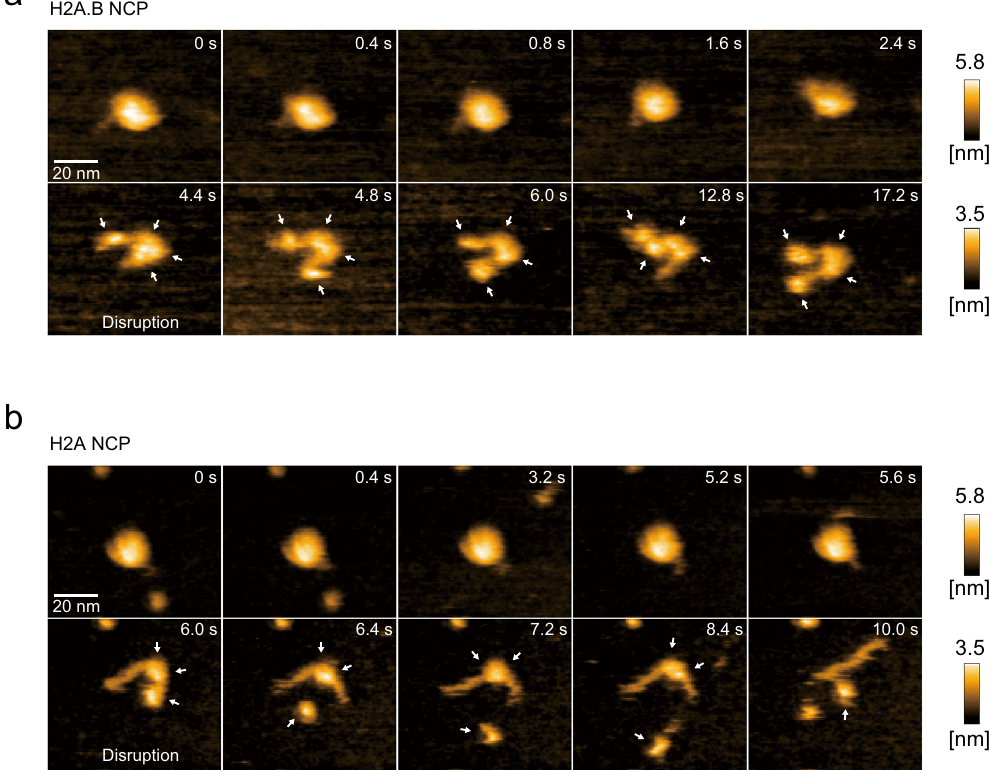
Fig. 4 HS-AFM observations of the NCPs containing H2A.B and H2A. a , b Sequential HS-AFM images of the H2A.B NCP ( a ) and the H2A nucleosome ( b ). Representative NCPs with about 6 nm heights are shown, and the dissociation processes of the NCPs elicited by scratching with the HS-AFM probe were monitored. White arrows indicate possible histone dimers. Scale bars are 20 nm. Frame rate is 2.5 frames per